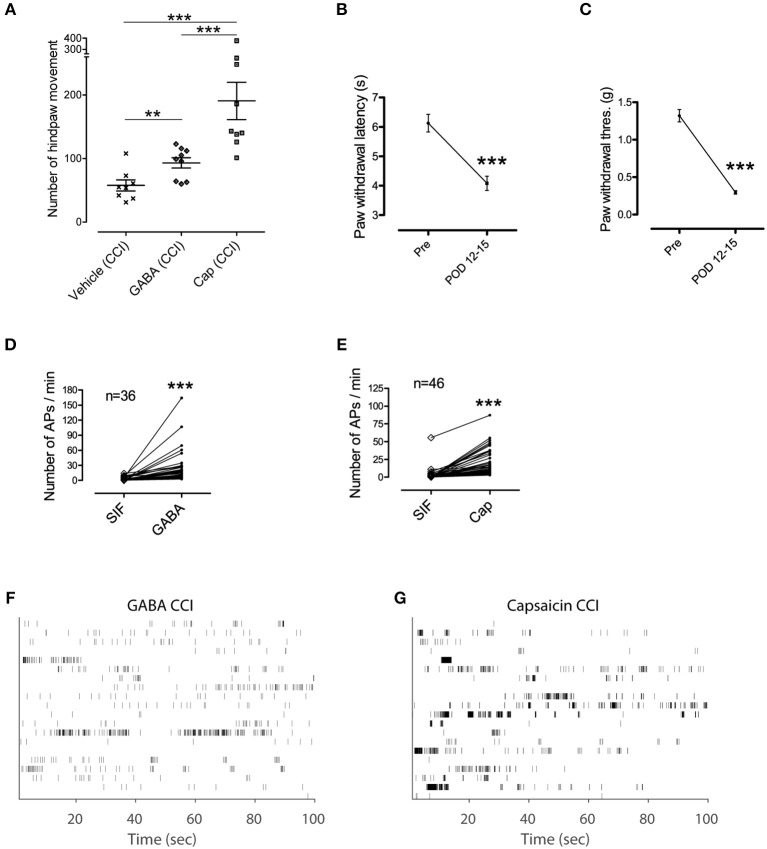
GABA induced nociceptive behavior in pathological condition. (A) Hindpaw movements in CCI mice after injection of vehicle (n = 8), GABA (n = 9), and capsaicin (n = 9). Note, that GABA induced an increase in movement. (B,C) Paw withdrawal test to measure pain and hypersensitivity to heat and mechanical stimuli (Wilcoxon signed rank test). Error bars represent s.e.m. (D,E) Spike counts in each single fiber during the control period of SIF and the corresponding responsive period to a stimulant in CCI mice. **P < 0.01, ***P < 0.001 (F,G) Time stamp of 20 randomly selected single fibers in each group of chemical responses in CCI mice i.e., GABA in (F) and capsaicin in (G).